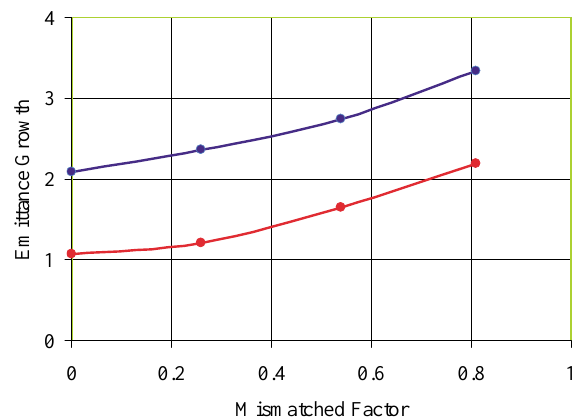
FIG. 13. (Color) Full emittance growth of five charge state beam versus mismatched factor in the focusing channel without errors (red dots) and with errors (blue